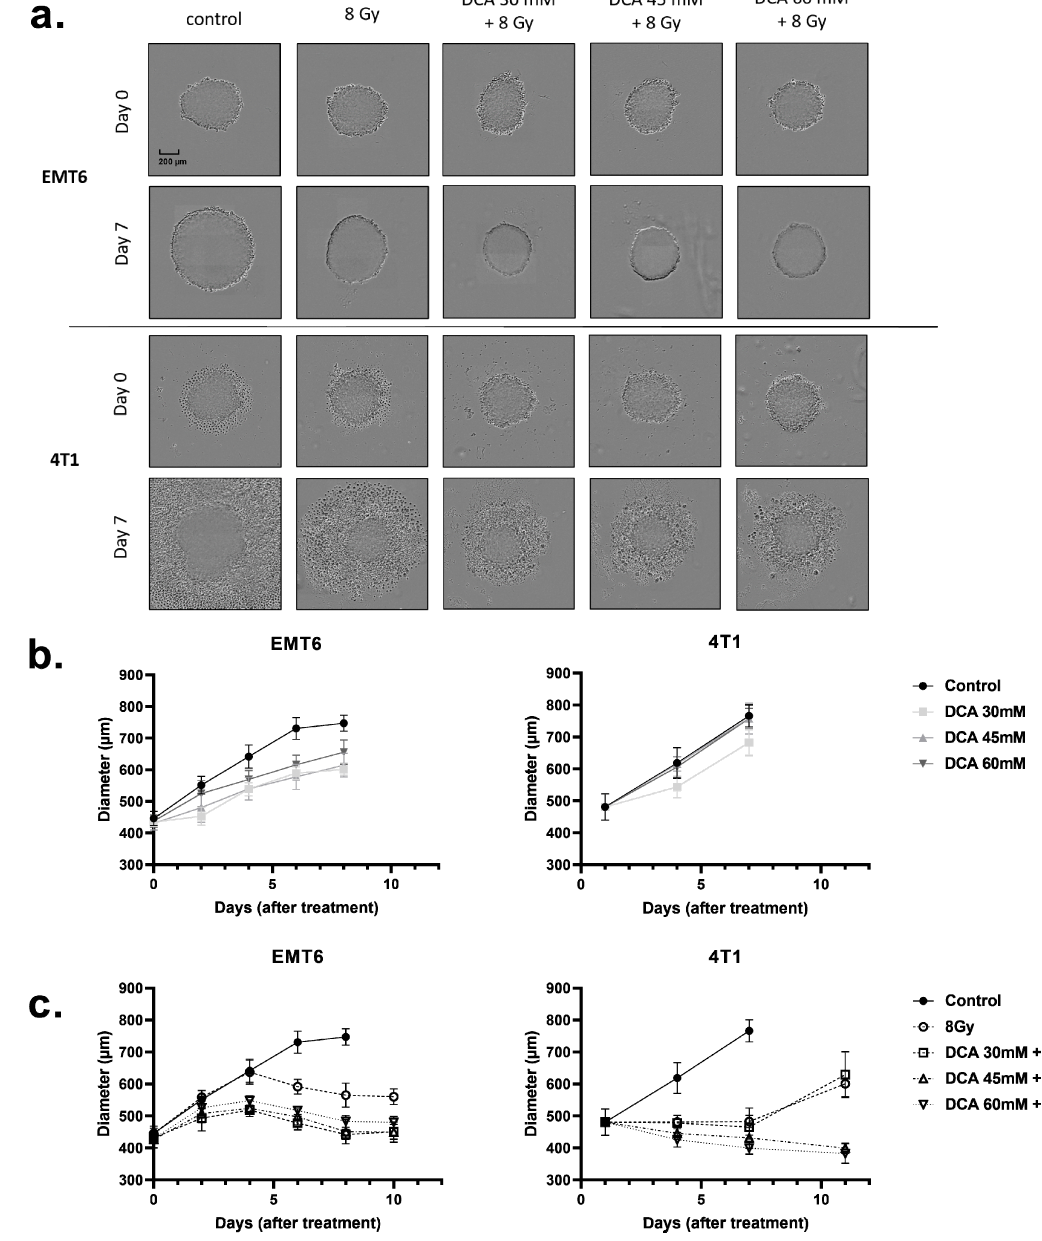
Figure 6. Treatment of DCA and 8 Gy radiation reduces the growth of EMT6 and 4T1 tumor spheroids. ( a ) Representative pictures and ( b,c ) time-dependent growth of EMT6 and 4T1 spheroids upon treatment with DCA at indicated concentrations and in combination with 8 Gy radiotherapy.